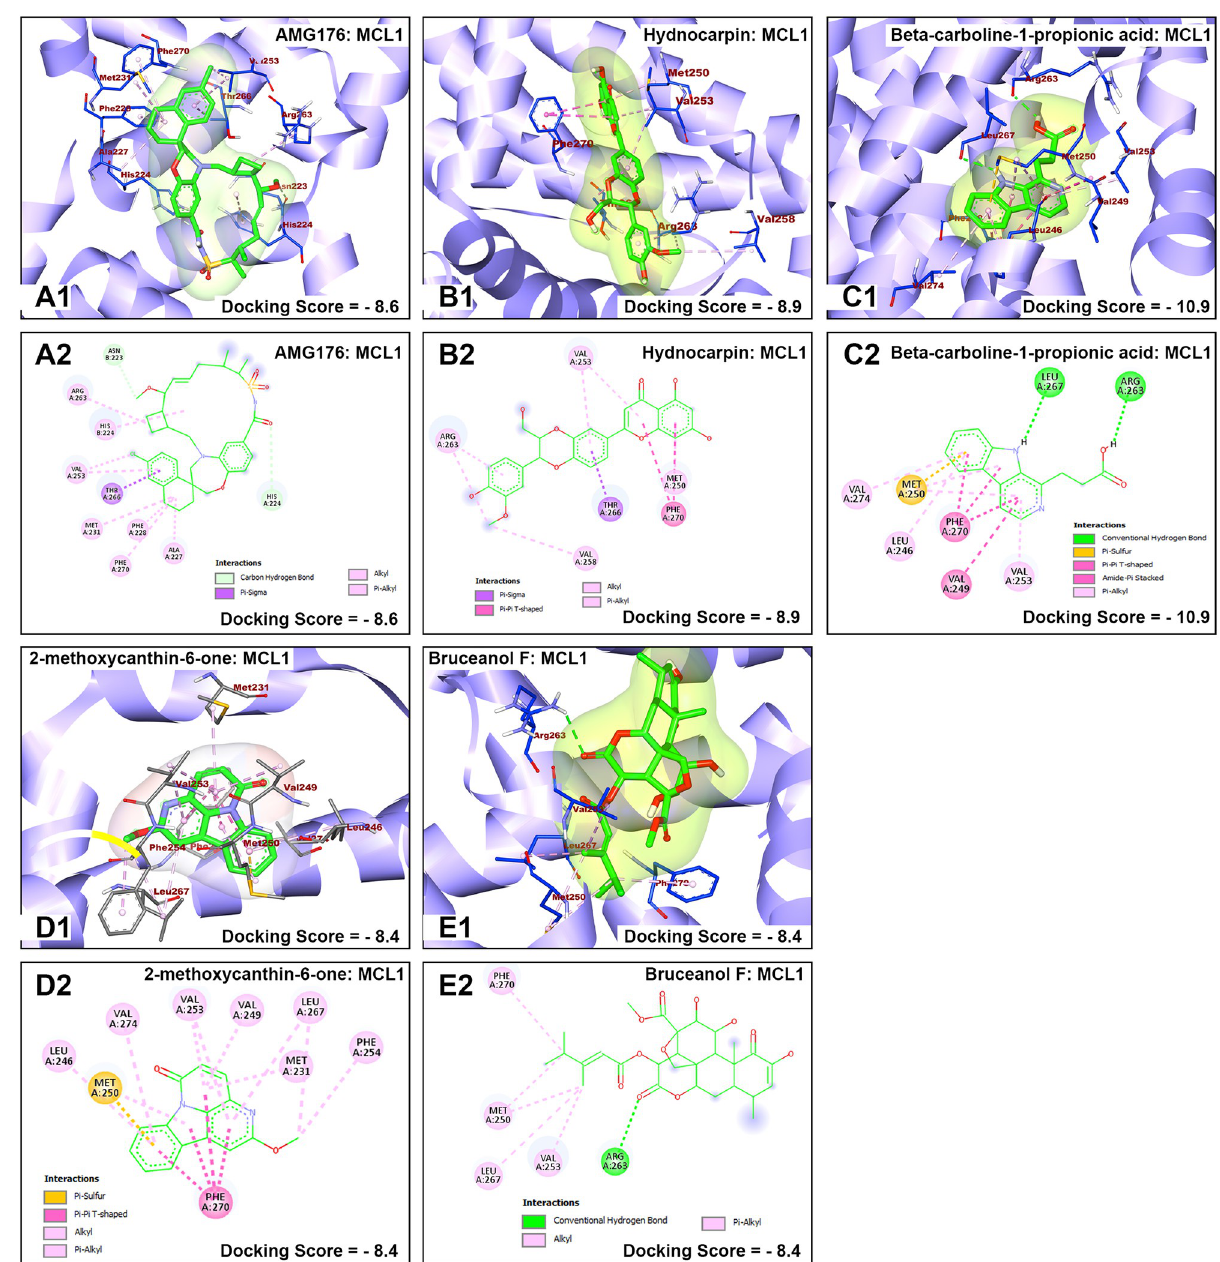
Fig 5. Molecular docking analysis of AMG176 and selected B . antidysentrica phytochemicals against MCL1 AML receptor. (1) 3D pose views of interaction of compounds with AML receptor MCL1. (2) 2D pose views of interaction of compounds with AML receptor MCL1.